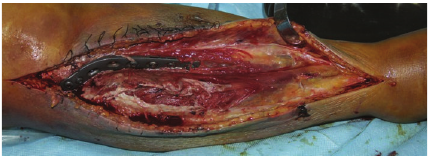
Figure 2: The muscle was found to be necrotic, foul smelling, and crepitant both superficially and